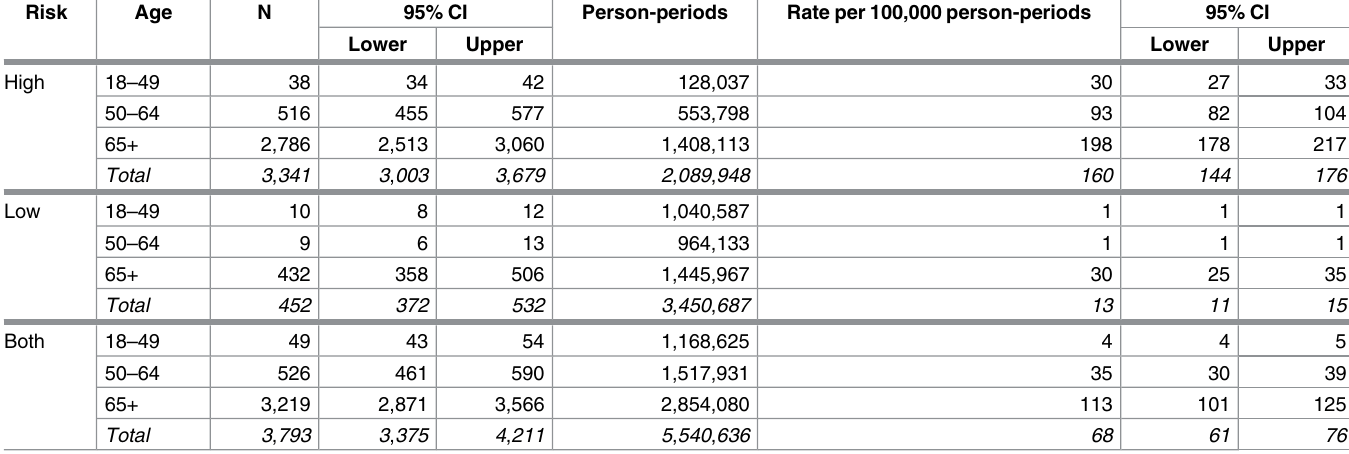
Table 4. Annual estimates of influenza-attributed mortality adjusted for respiratoryor circulatory cause of death by risk and age group averaged over five respiratoryseasons. Risk